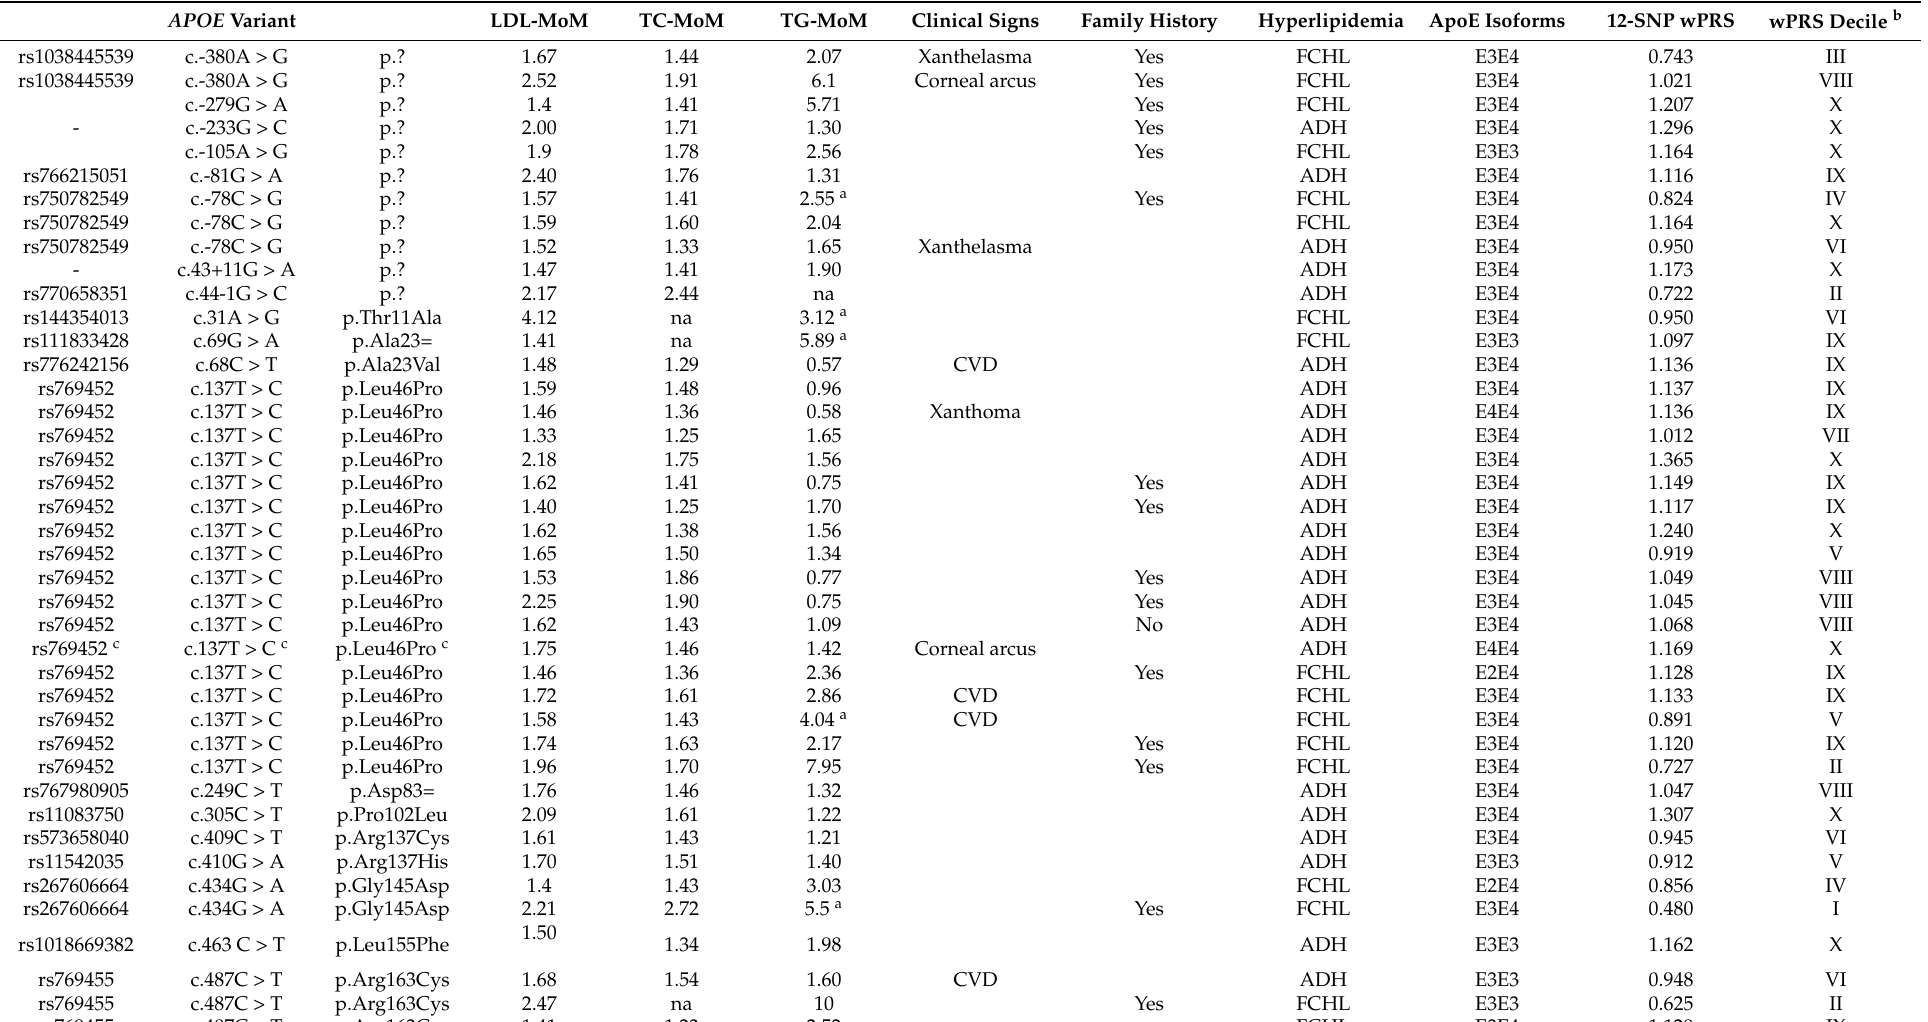
Table 1. Description of the 76 probands with